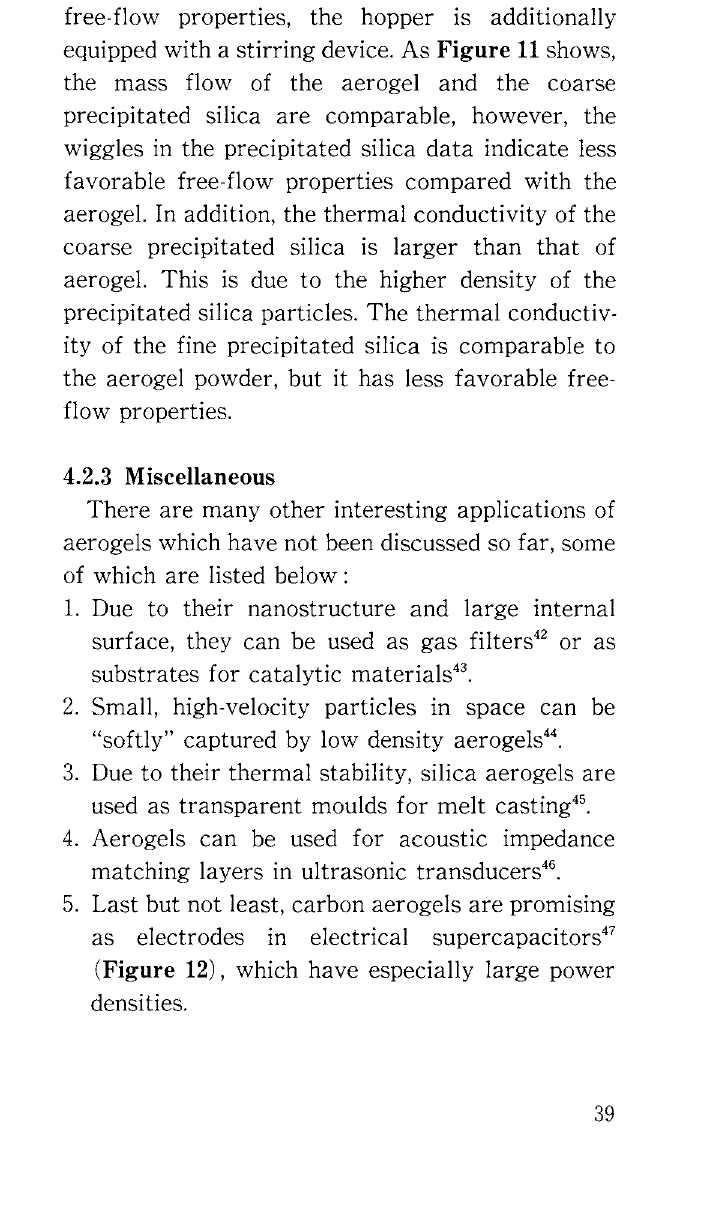
Fig. 10 Aerogel-superinsulated phase change heat storage tank developed by Lingerer & Reich/Germany. 10). The evacuated aerogel insulation has a thick·